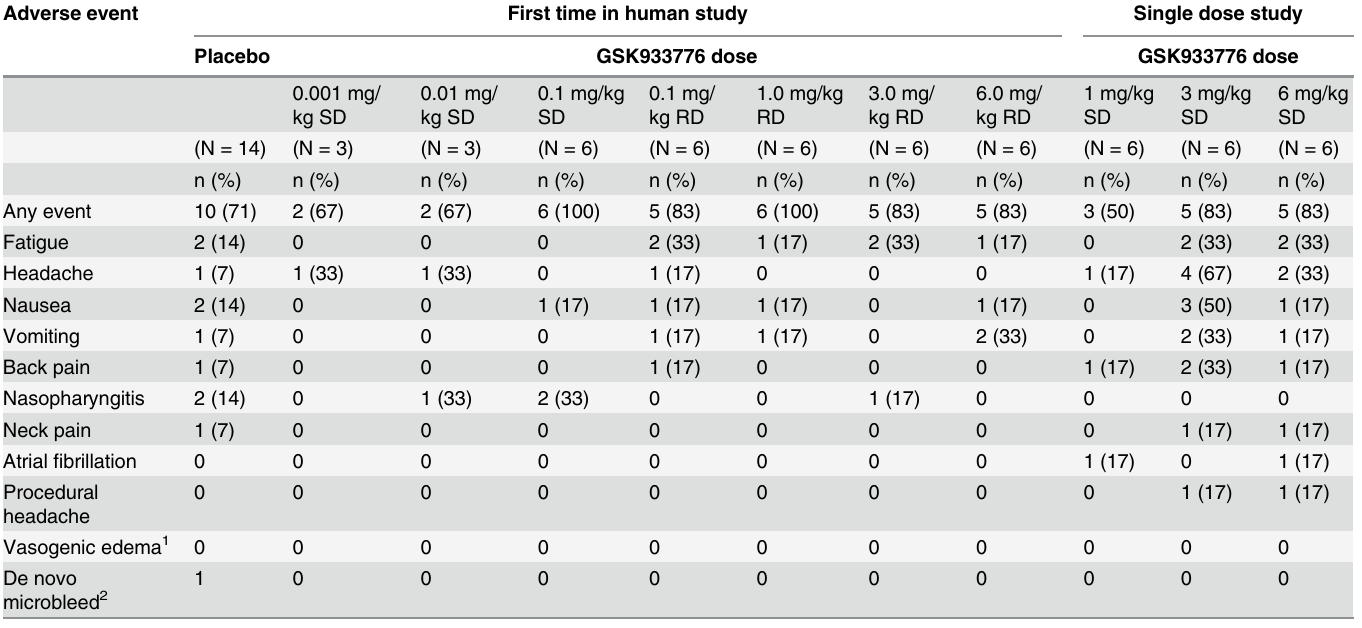
SD = single dose; RD = repeat dose.